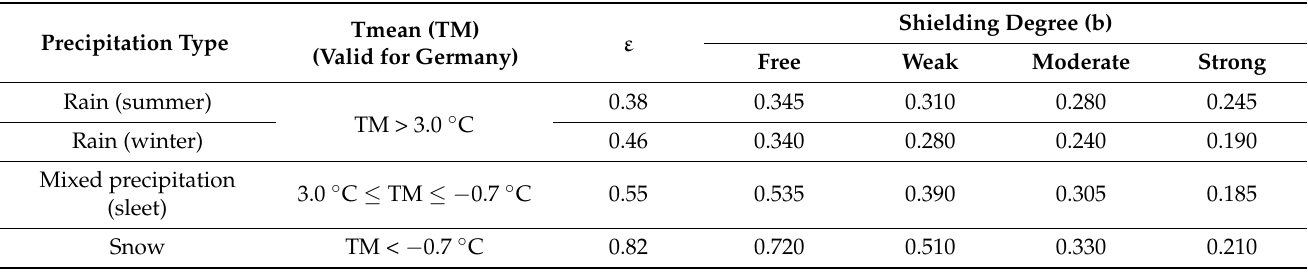
Table A2. The dependency of coefficients of the correction function (b and ε in Equation (1)) on precipitation type and shielding degree, Richter (1995). Remark: the classification of precipitation types based on temperature is only valid for